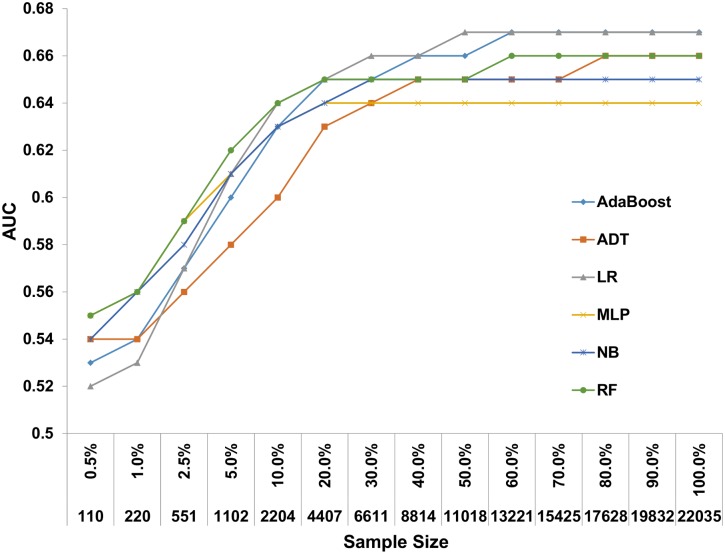
Predictive performance of day 100 NRM prediction models with increasing sample size.A gradually increasing sample from the experimental dataset was introduced to 6 machine learning algorithms. Prediction models were developed for each incremental step and their discriminative performance is plotted on the Y axis. Alternating decision tree (ADT), Logistic regression (LR), Multilayer perceptron (MLP), Naïve base (NB), Random forest (RF).